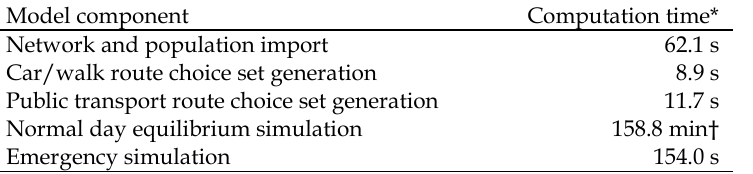
Table 1. Computation time per model